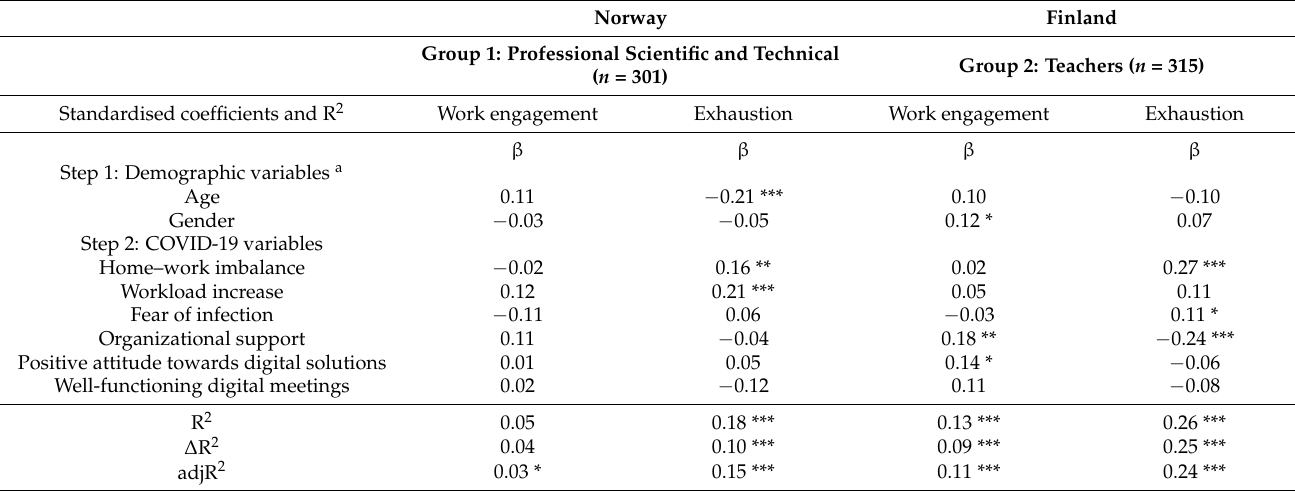
Table 3. Regression results of occupational Groups 1 and